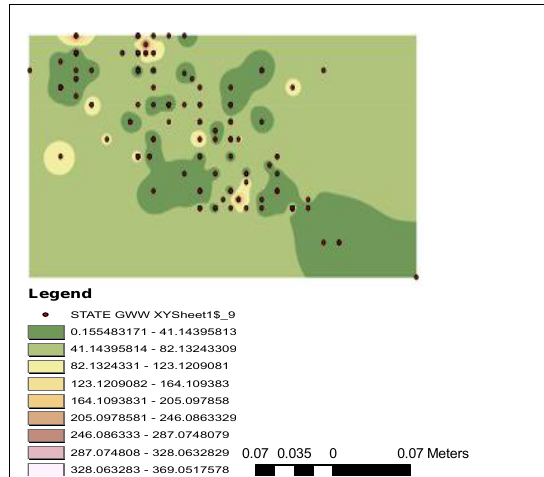
Fig (9) Sulfate Distribution mg/l (SO4) Ground- water Quality Map for sulfate distribution (Figure 9) derived shows only 6 wells out of 159 with high sulfate concentration mainly in south khartoum and part of the city where the groundwater with SO4 concentration more than permisiple limit (250 mg/l) , and 98% of wells within the permisiple limits(WHO standard)